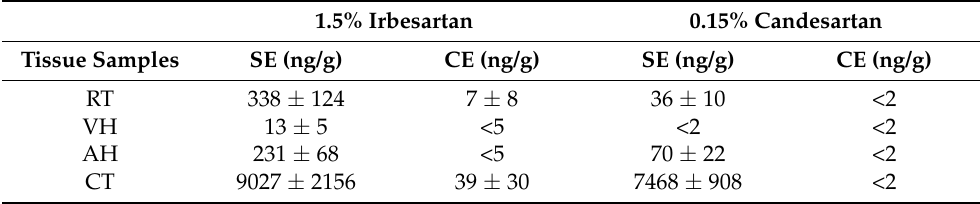
Table 3. Tissue concentrations of irbesartan and candesartan after multiple doses of 1.5% irbesartan or 0.15% candesartan in the study (SE) and the control eye (CE). Data are shown as means (C mean ) ±